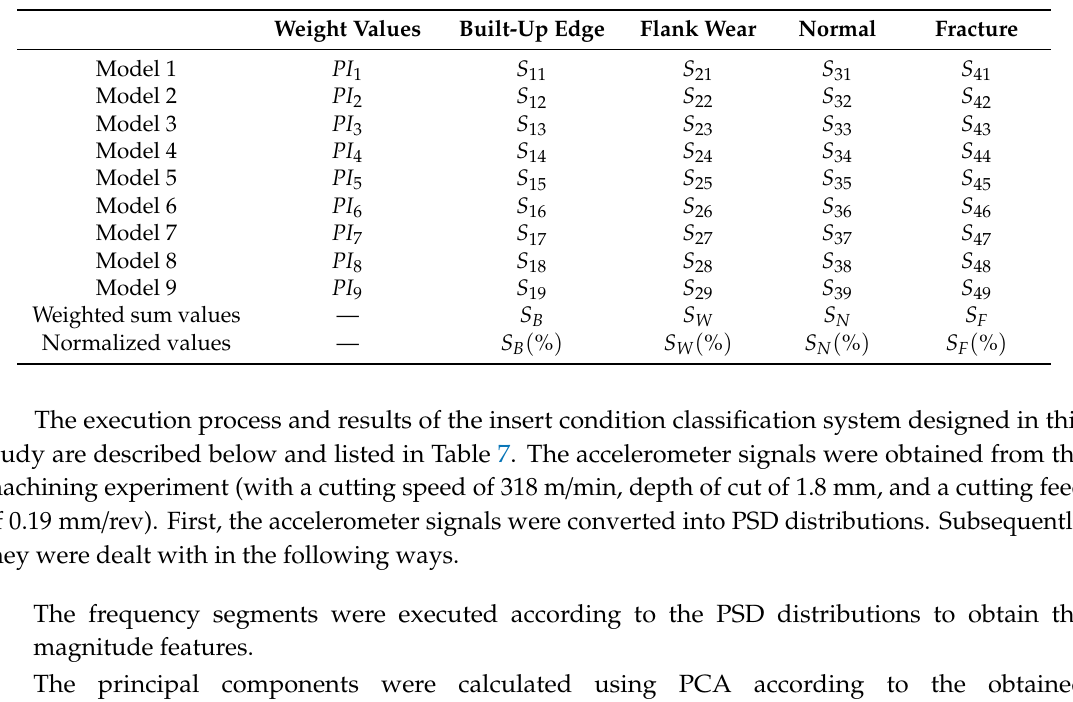
Table 6. Insert condition classification calculation